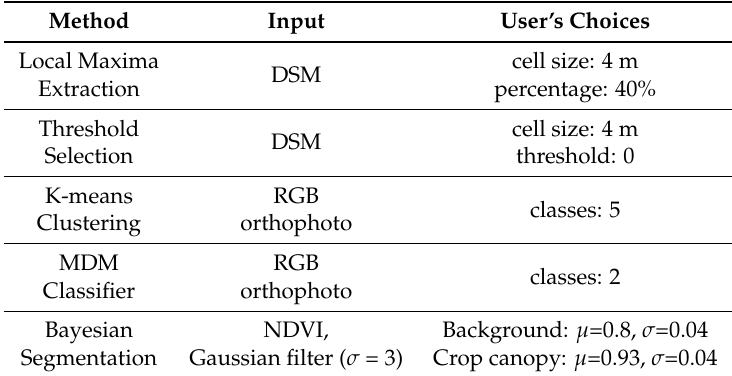
Table 7. Pear orchard site: parameters for the best results of each detection method.